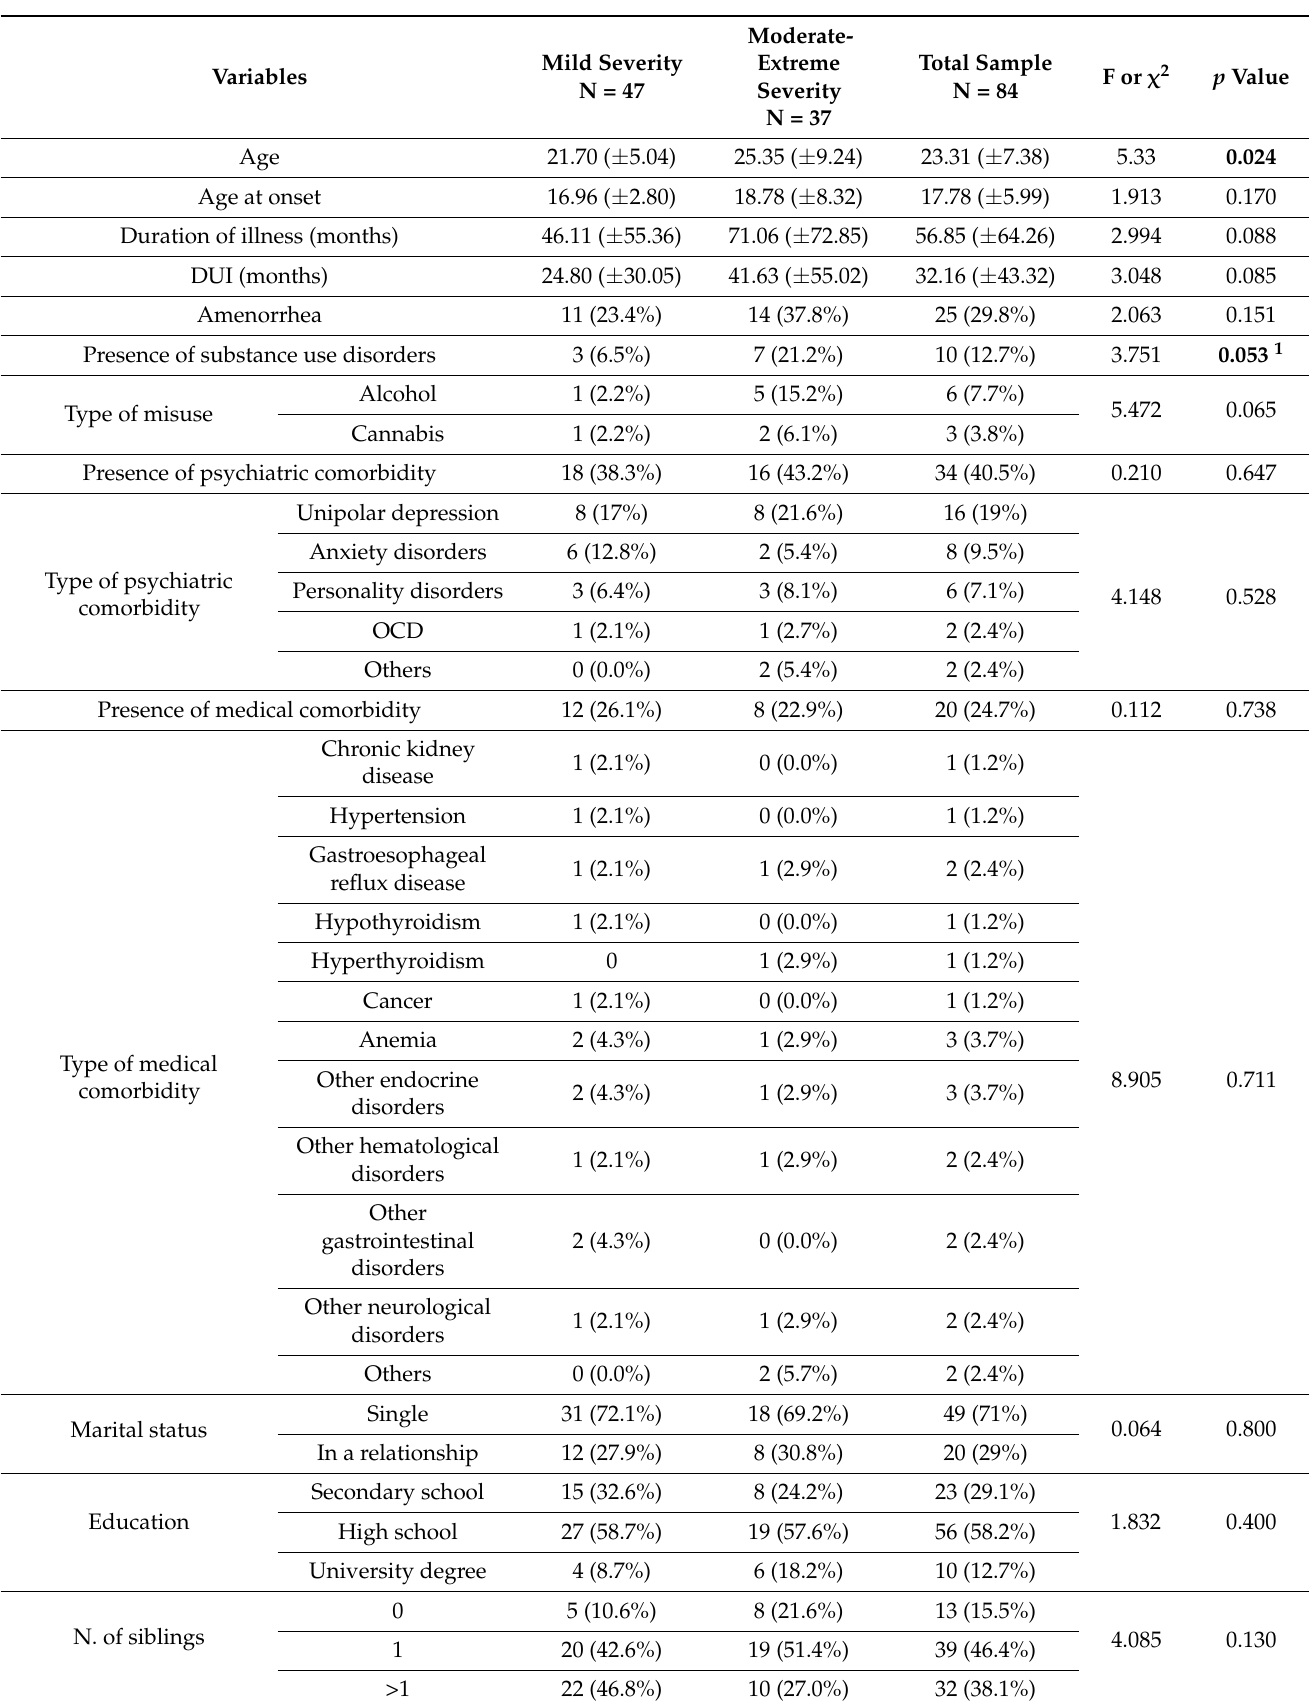
Table 1. Clinical variables and peripheral biomarkers of the total sample and of the two groups identified according to the severity of